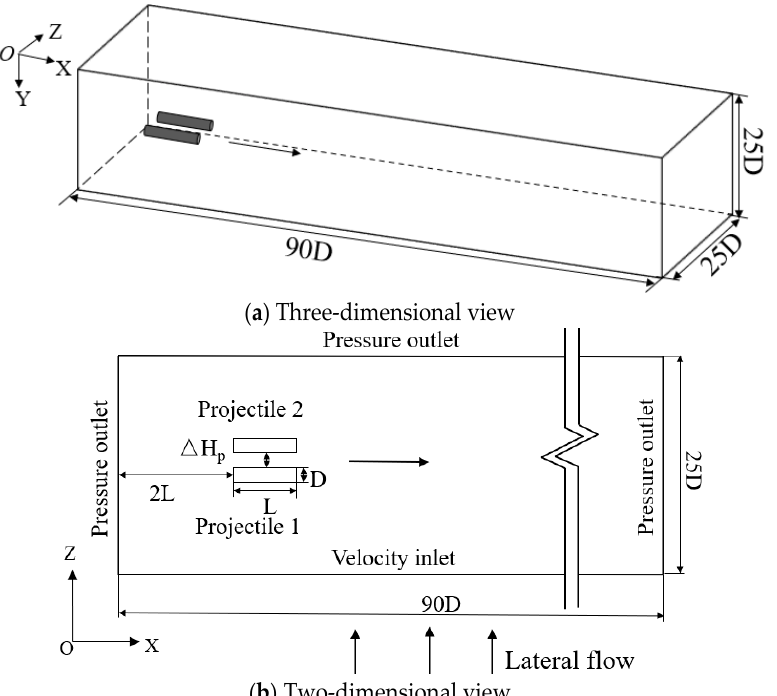
Figure 2. Schematic diagram of the computational domain and boundary conditions of the parallel projectiles.